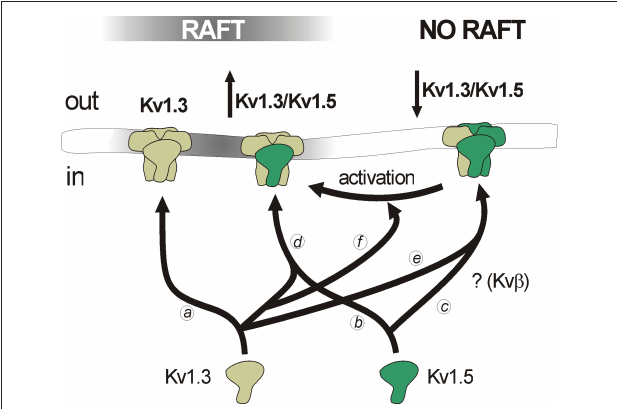
FIguRE 2 | Distinct voltage-dependent K + channel compositions trigger different membrane surface microdomain targeting. While Kv1.3 efficiently targets to lipid rafts (a), Kv1.5 targeting depends on partnership interactions. Kv1.5 localizes in rafts when overexpressed in heterologous systems (b). However, the channel does not target to these microdomains in native tissues, probably due to the presence of interacting subunits yet to determine (e.g., Kv β 2.1) (c). In leukocytes, heterotetrameric channels with high Kv1.3/ Kv1.5 ( ↑ Kv1.3/Kv1.5) ratio localize in rafts (d). On the contrary, low Kv1.3/Kv1.5 ratios ( ↓ Kv1.3/Kv1.5) impair raft localization of the channels (e). Macrophage activation, which triggers a selective increase of Kv1.3 subunits, generates high Kv1.3/Kv1.5 ratio heteromers which target back to lipid rafts